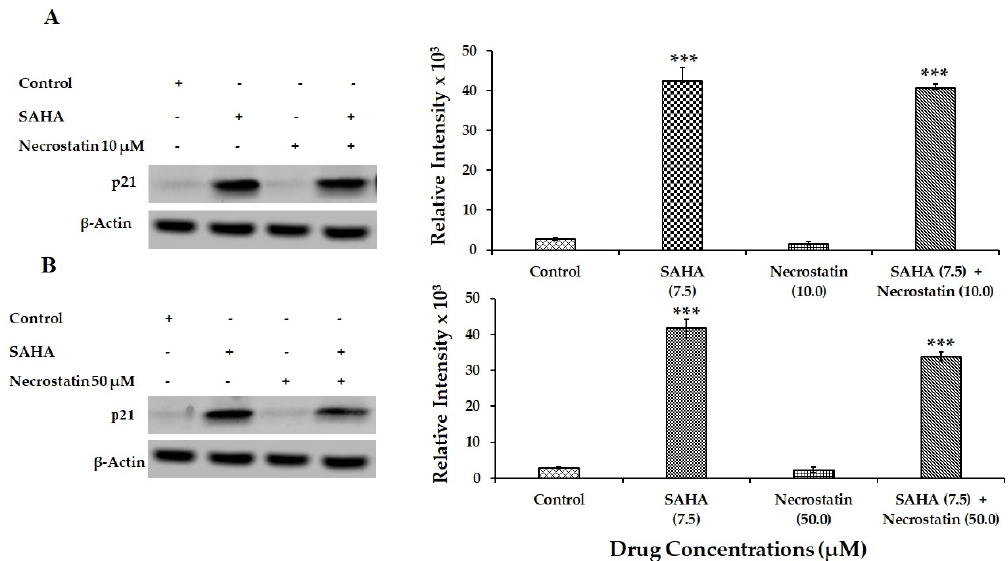
Figure 10. Effect of SAHA and Necrostatin treatments on p21 expression in MCF-7 cells. ( A ) Effect of SAHA (7.5 µ M) and Necrostatin (10 µ M) on p21 levels in MCF-7 cells after 24 h treatment. ( B ) Modulation of p21 protein levels in MCF-7 cells after 24 h treatments with SAHA (7.5 µ M) Necrostatin (50 µ M) and combination. The level of significance is indicated as *** p < 0.001 compared to control.